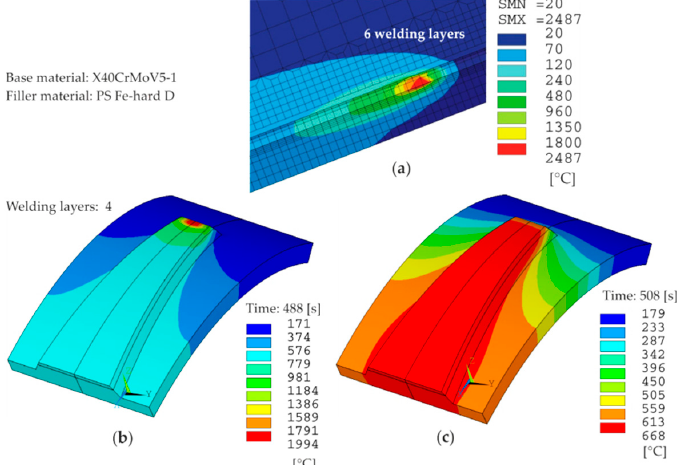
Figure 6. Temperature distribution for additive PMD tool: ( a ) linear thermal deposition; ( b ) weaving thermal deposition and ( c ) component cooling.